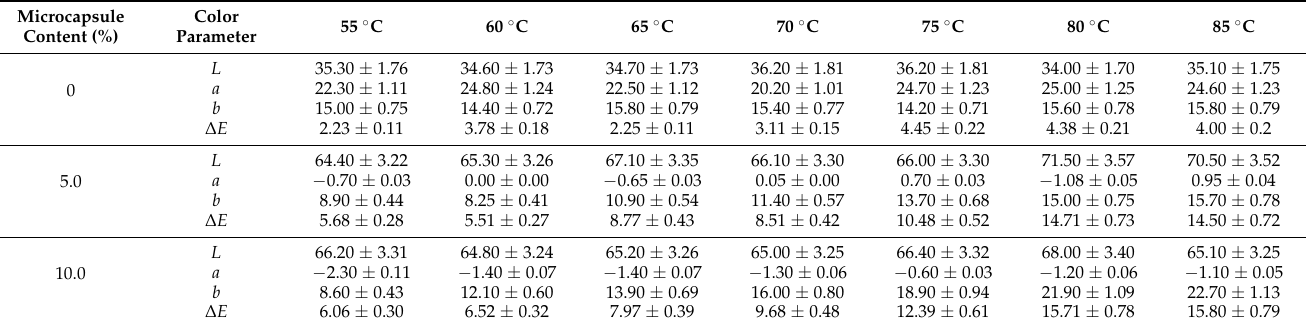
Table 8. Chromaticity value and color difference of coatings with different microcapsule contents as temperature